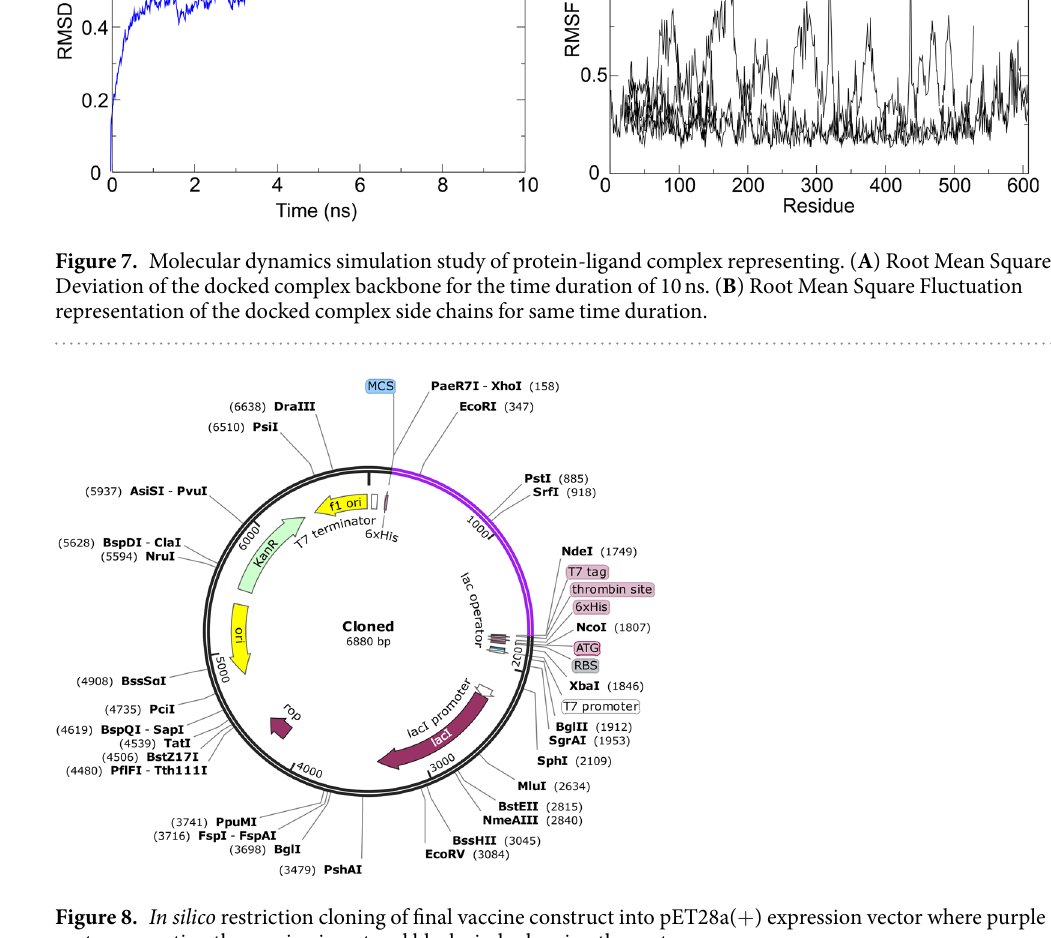
Figure 8. In silico restriction cloning of final vaccine construct into pET28a( + ) expression vector where purple part representing the vaccine insert and black circle showing the